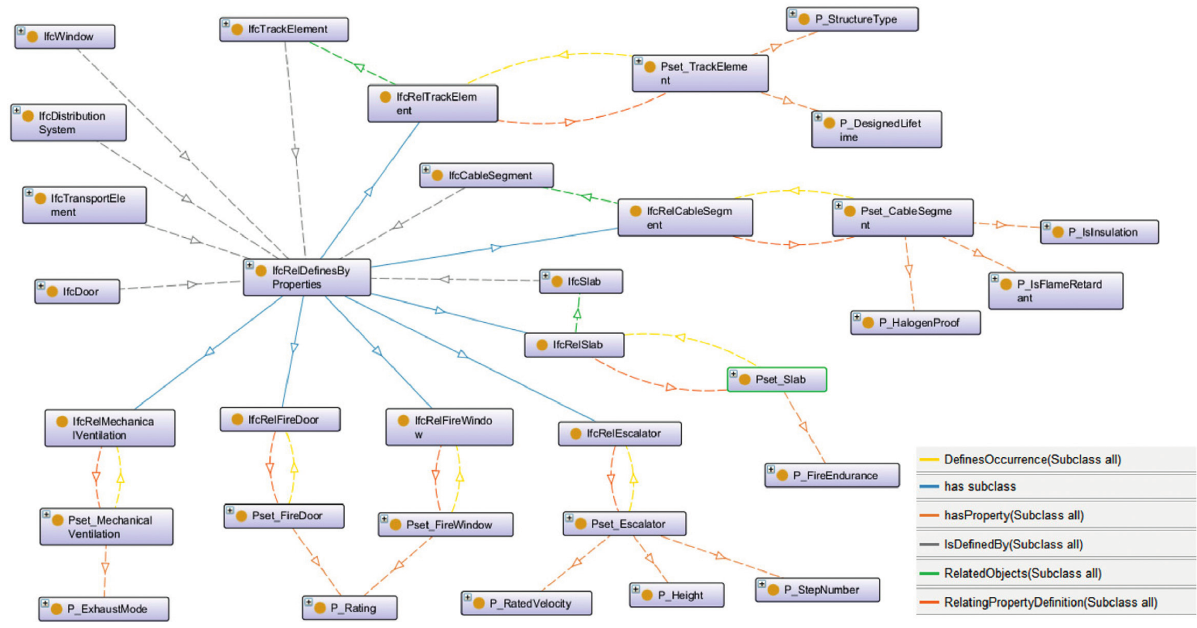
Figure 14: The property extension in